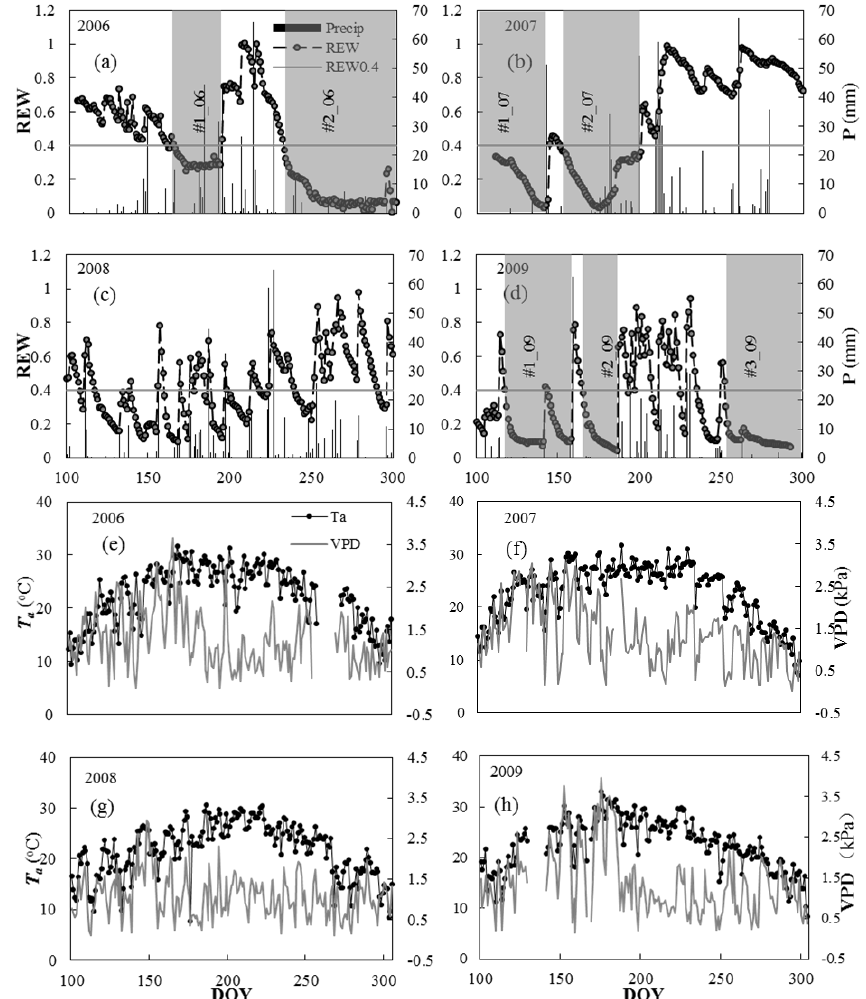
Figure 2. The seasonal variation of environmental conditions during 2006–2009, (a–d) the relative extractable water (REW; drought periods longer than 20 days are shaded), daily sum of precipitation ( P ); (e–h) daytime mean air temperature ( T a ) , daytime mean air vapor deficit